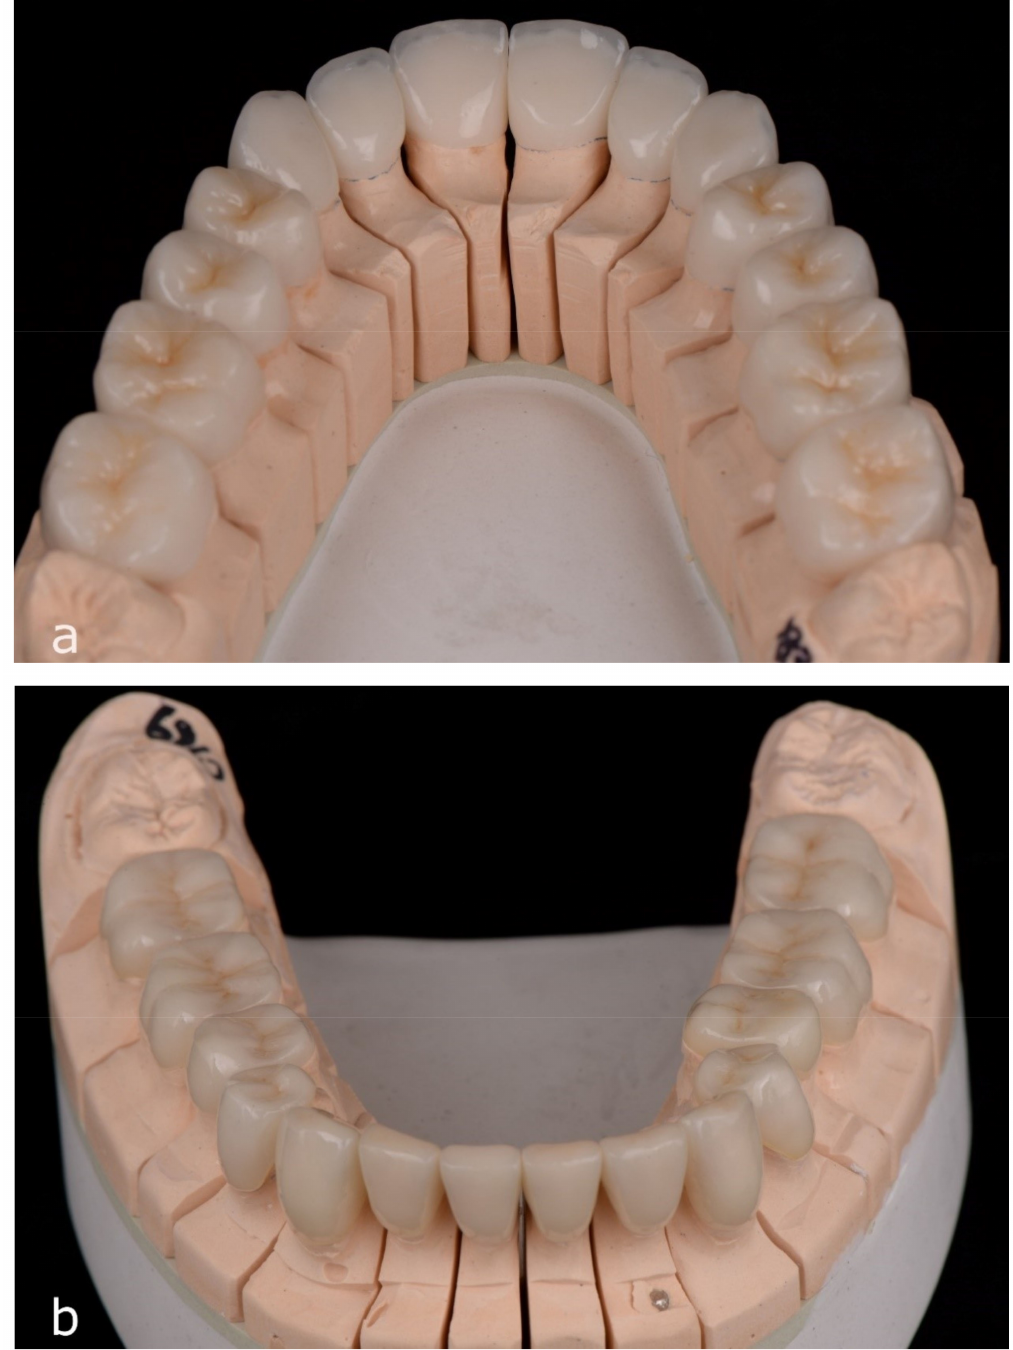
Figure 9. Final restorations with pressed lithium disilicate: ( a ) maxillary final restorations and ( b ) mandibular final